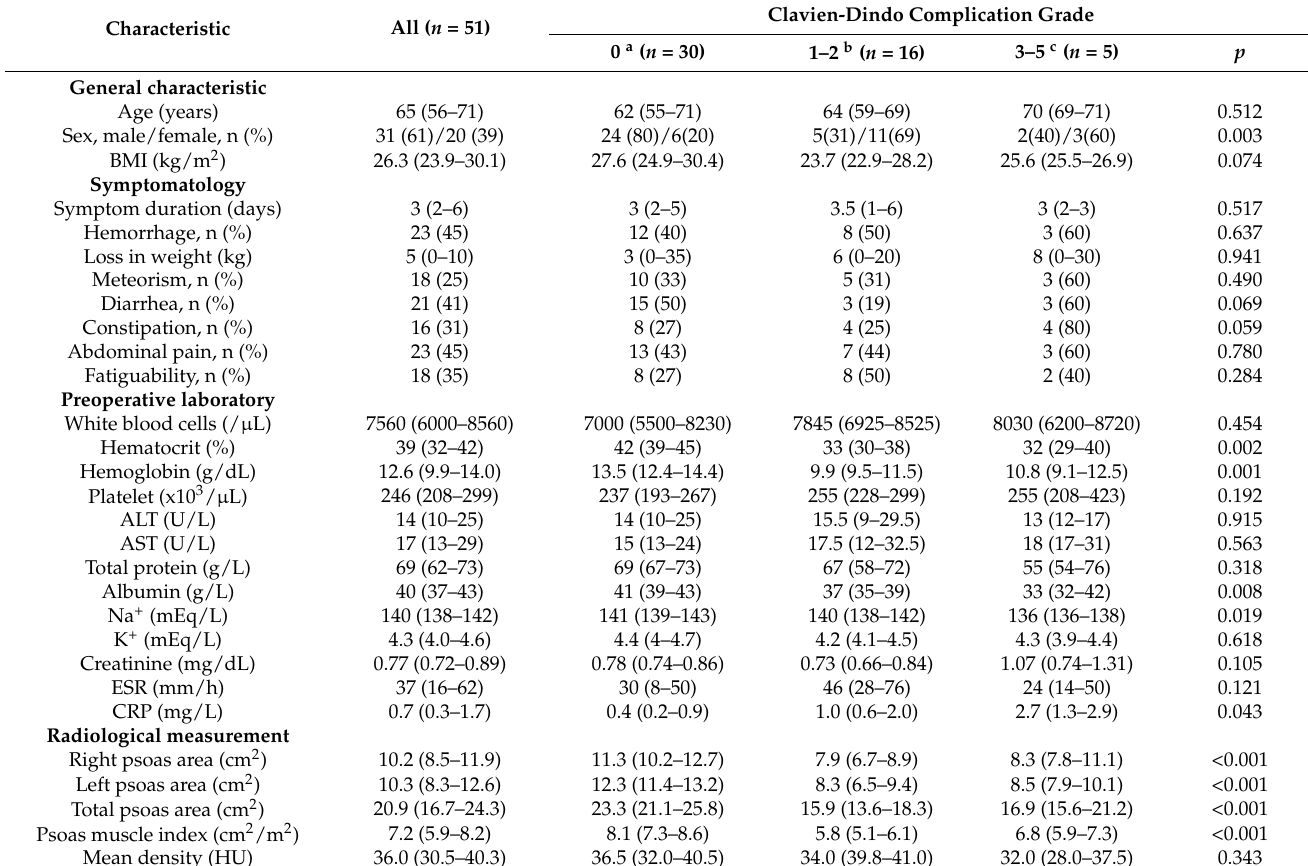
Table 4. Patient characteristics by Clavien-Dindo complication